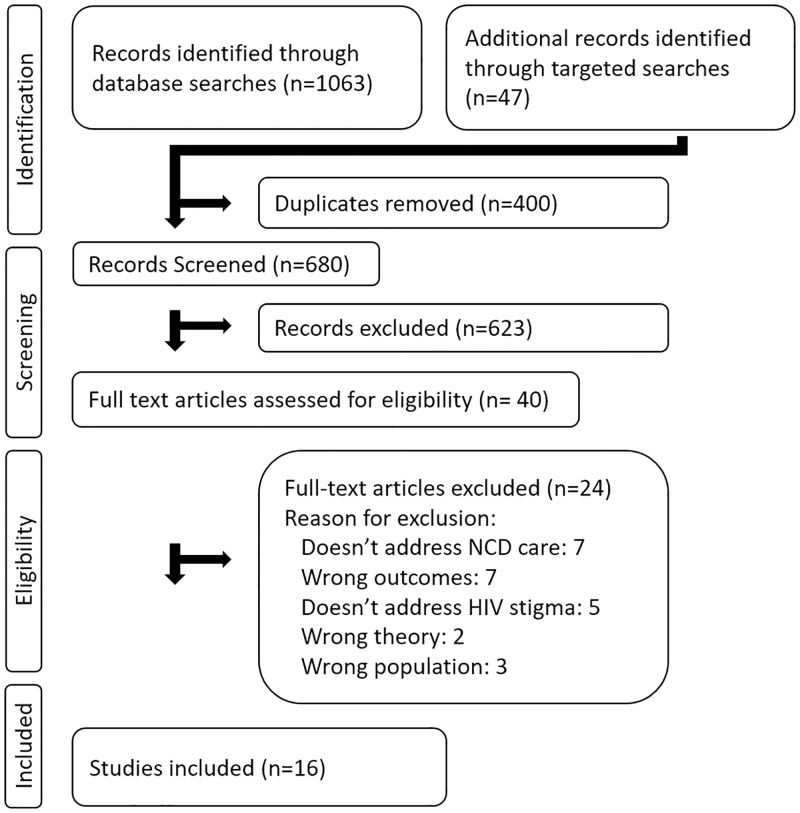
PRIMSA flowchart.